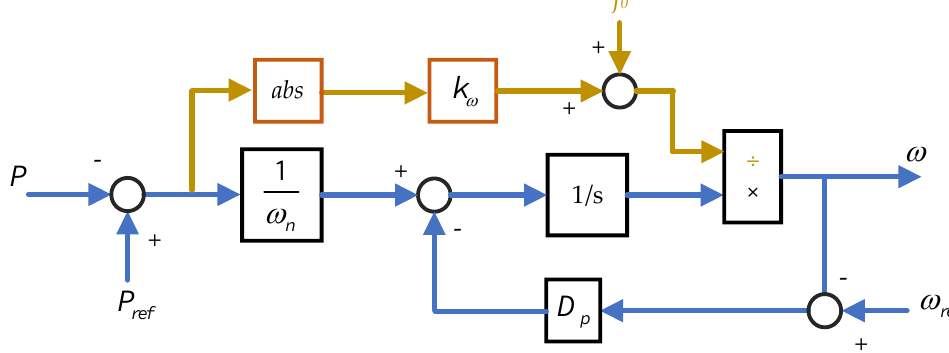
Figure 11. Active power control link of VSG with power feedback.